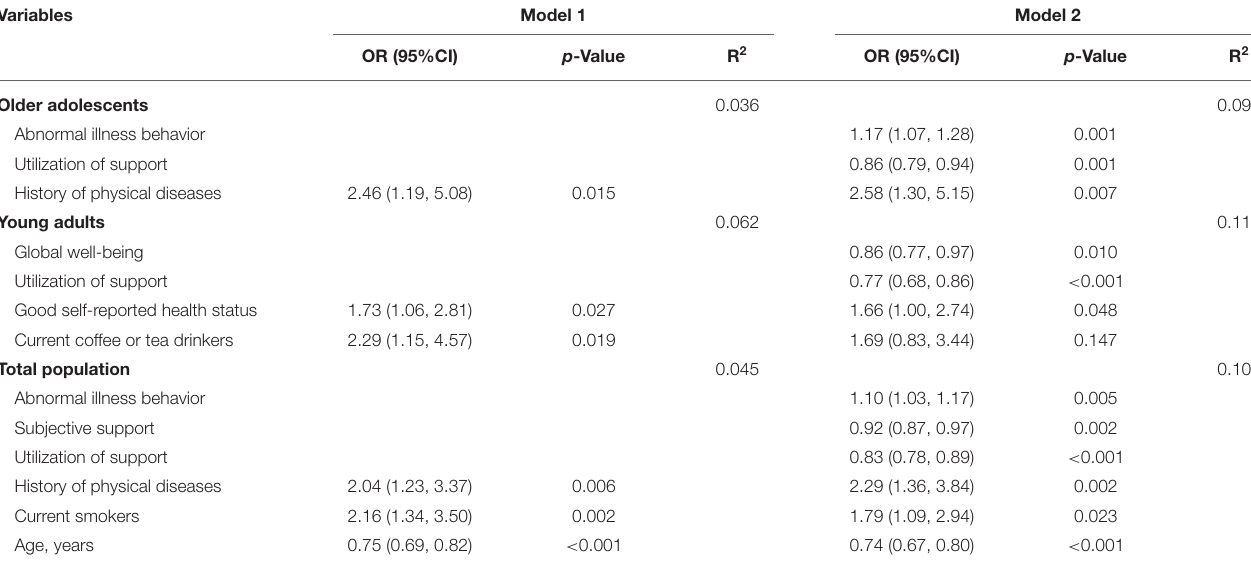
TABLE 3 | Multivariate conditional logistic regression for vaccine hesitancy risk among older adolescents and young